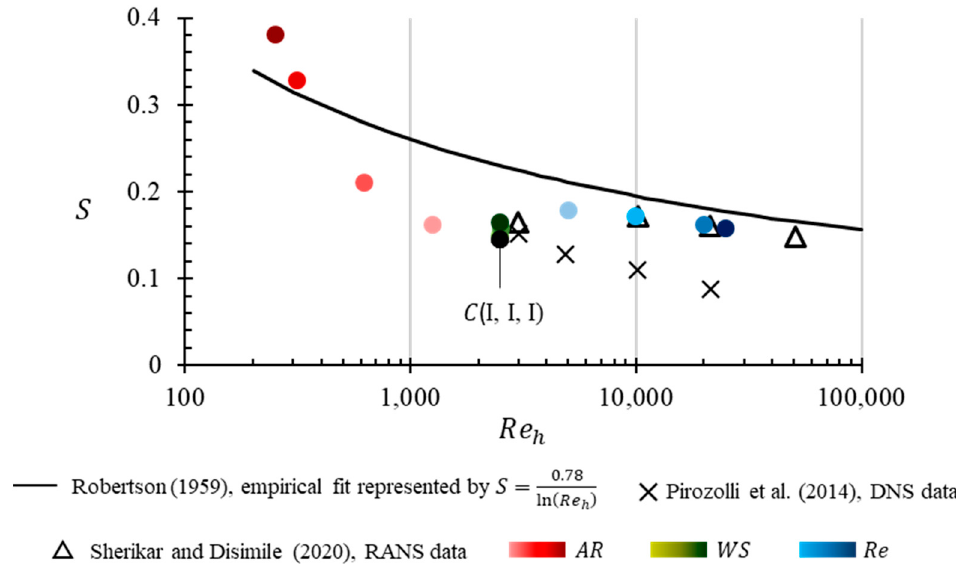
Figure 10. Influence of parameters on centerline slope. Data plotted against Reynolds number based on height, Re h , for comparison of data from literature. All color-coded data and C (I, I, I): current study. DNS data is extracted from Pirozolli et al. [31], RANS data is extracted from Sherikar and Disimile [26] and empirical fit plotted from Robertson [30].